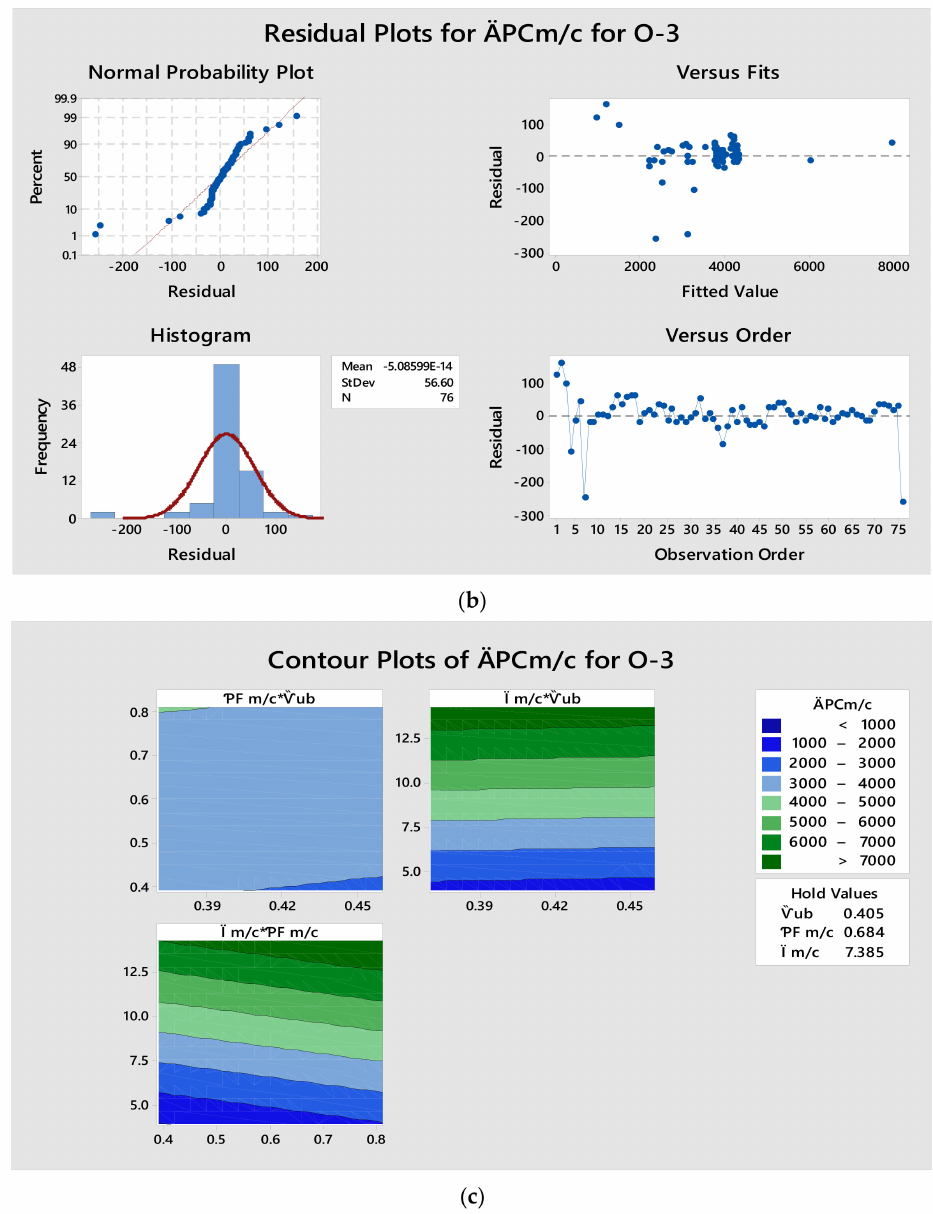
Figure 6. ( a ) Main effects plot for O-3. ( b ) Residuals plot for O-3. ( c ) Contour plots for